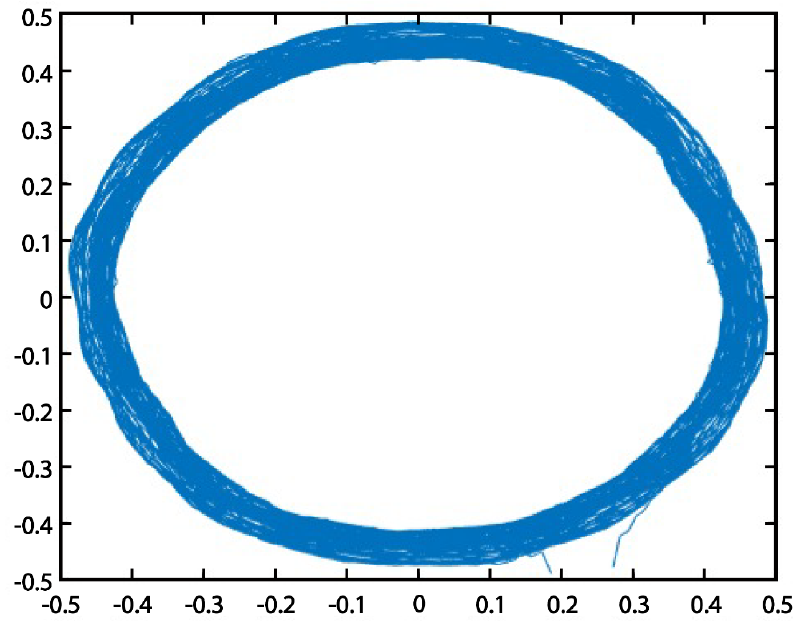
Figure 10. Park vectors of the current signal.